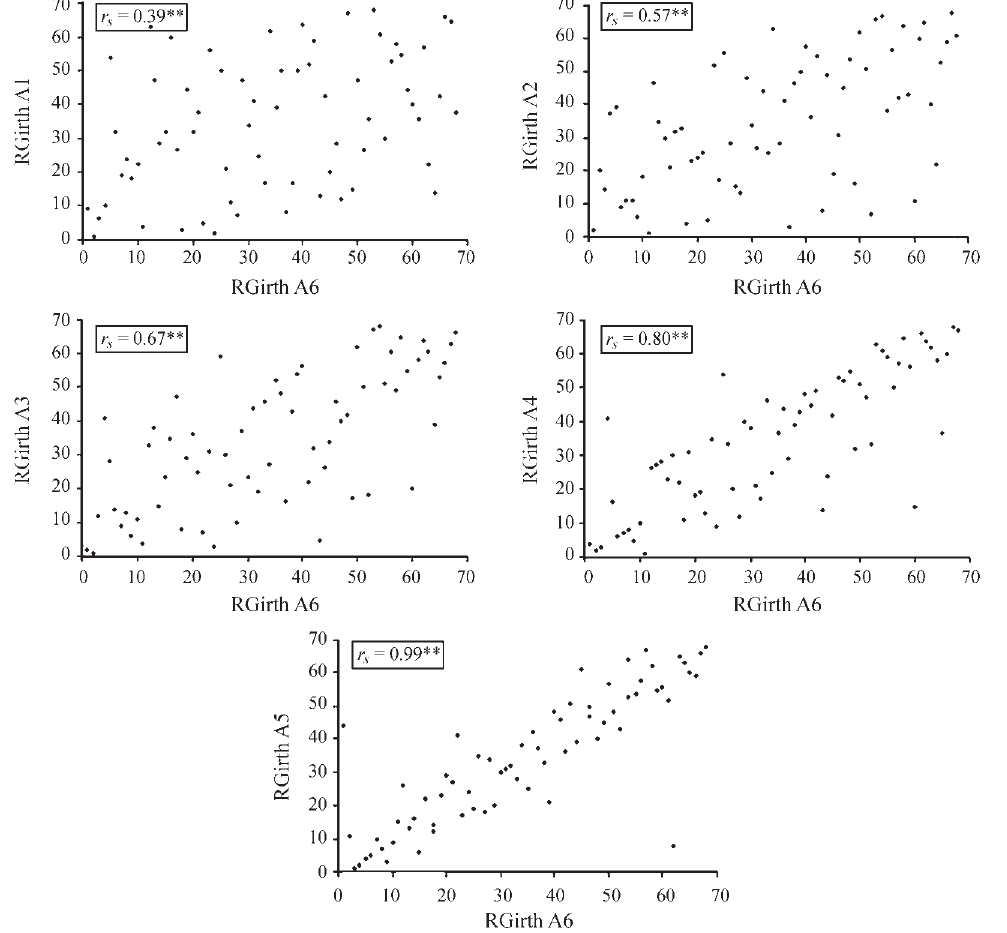
Figure1 -Scatterplotranksrecordedatagesixranksatage1( i ),2( ii ),3( iii ),4( iviv )and5( v )formeangirthAvaluesof68clones.Therankofthegirth A values at 1 year, 2 years, etc are indicated as Rgirth A1, Rgirth